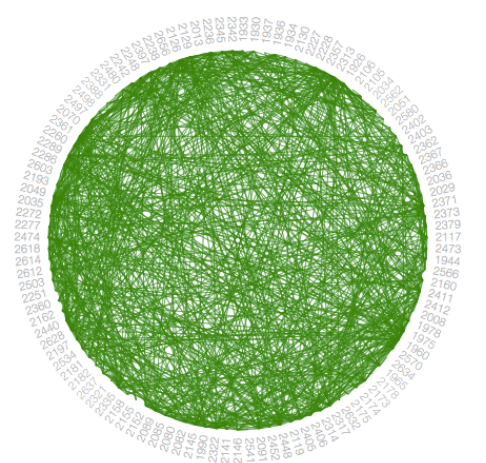
Figure A15. Representation of a graph using hierarchical edge bundling visualization with low bundling